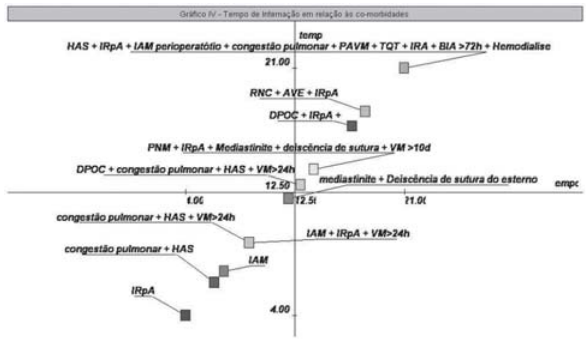
Fig. 4 - Relação do tempo de internação na UTI (dias) e co- morbidades intercorrentes no pós-operatório